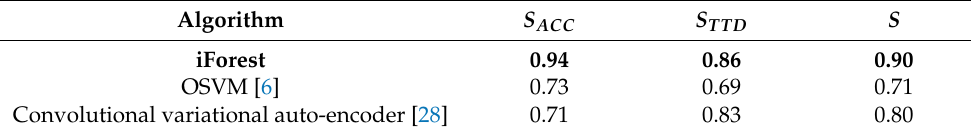
Table 5. S ACC , TTD , and S in stage 2 of using 6 h